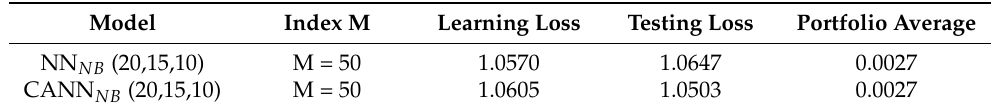
Table 10. Testing loss, learning loss, and portfolio average of the nagging predictor (M = 50) for the NN (20,15,10) and CANN (20,15,10) models under the negative binomial distributional assumption.